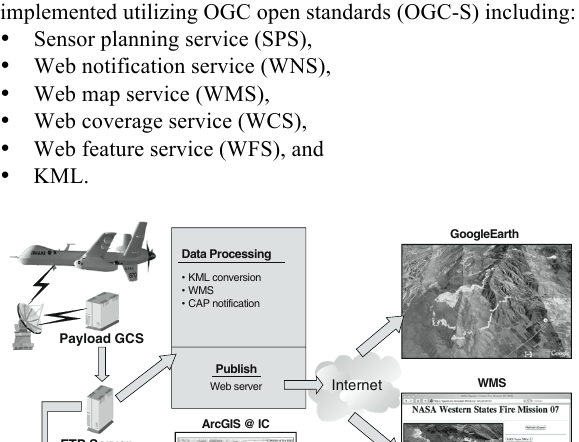
TABLE 4. 2008 WESTERN STATES FIRE MISSION SUMMARY Flight date